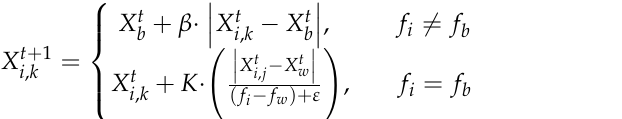
Crossing probability = 0.8; Variation probability = 0.05 Acceleration factor c1, c2 = 1.5; Inertia factor w = 0.8 ABC